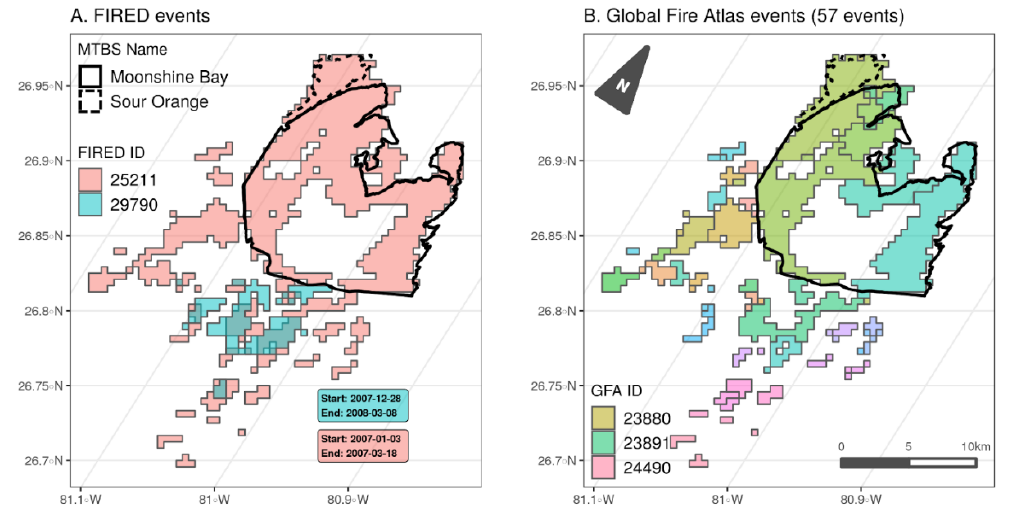
Figure 3. Comparison of ( A ) FIRED and ( B ) Global Fire Atlas delineated events for the Sour Orange fire (started 9 February 2007), the Moonshine Bay fire (started 24 February 2007), and a third unnamed event, FIRED event #29790 (started 28 December 2007, and continued into March of 2008). The FIRED product joins the two intra-year burns (#25211) and delineates a third event (#29790) that reburns some of the same pixels. The dark outlines, bold and dashed, show the MTBS fire perimeters for the Sour Orange and Moonshine Bay fires. Note that MTBS does not include unburned patches within perimeters. Panel ( B ) shows the Global Fire Atlas (with an abridged legend showing 3 of 57 colors), which segments the same MODIS burned area pixels into 57 events and provides no delineation of overlapping reburns.